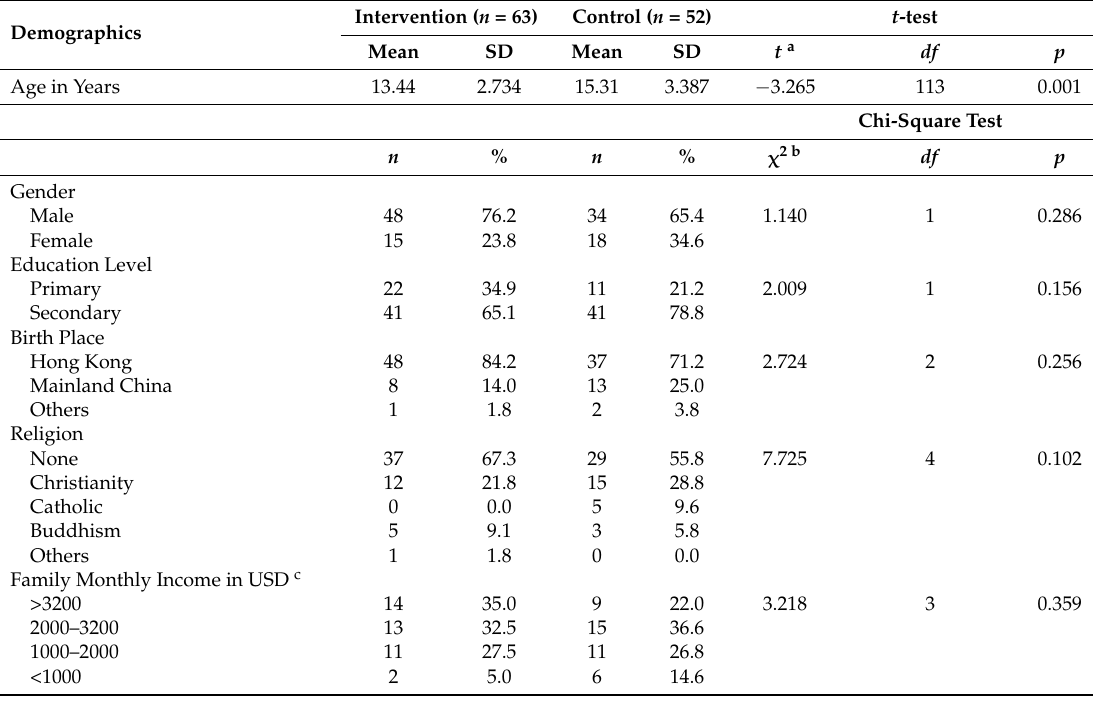
Table 1. Demographic characteristics of the sample ( n =